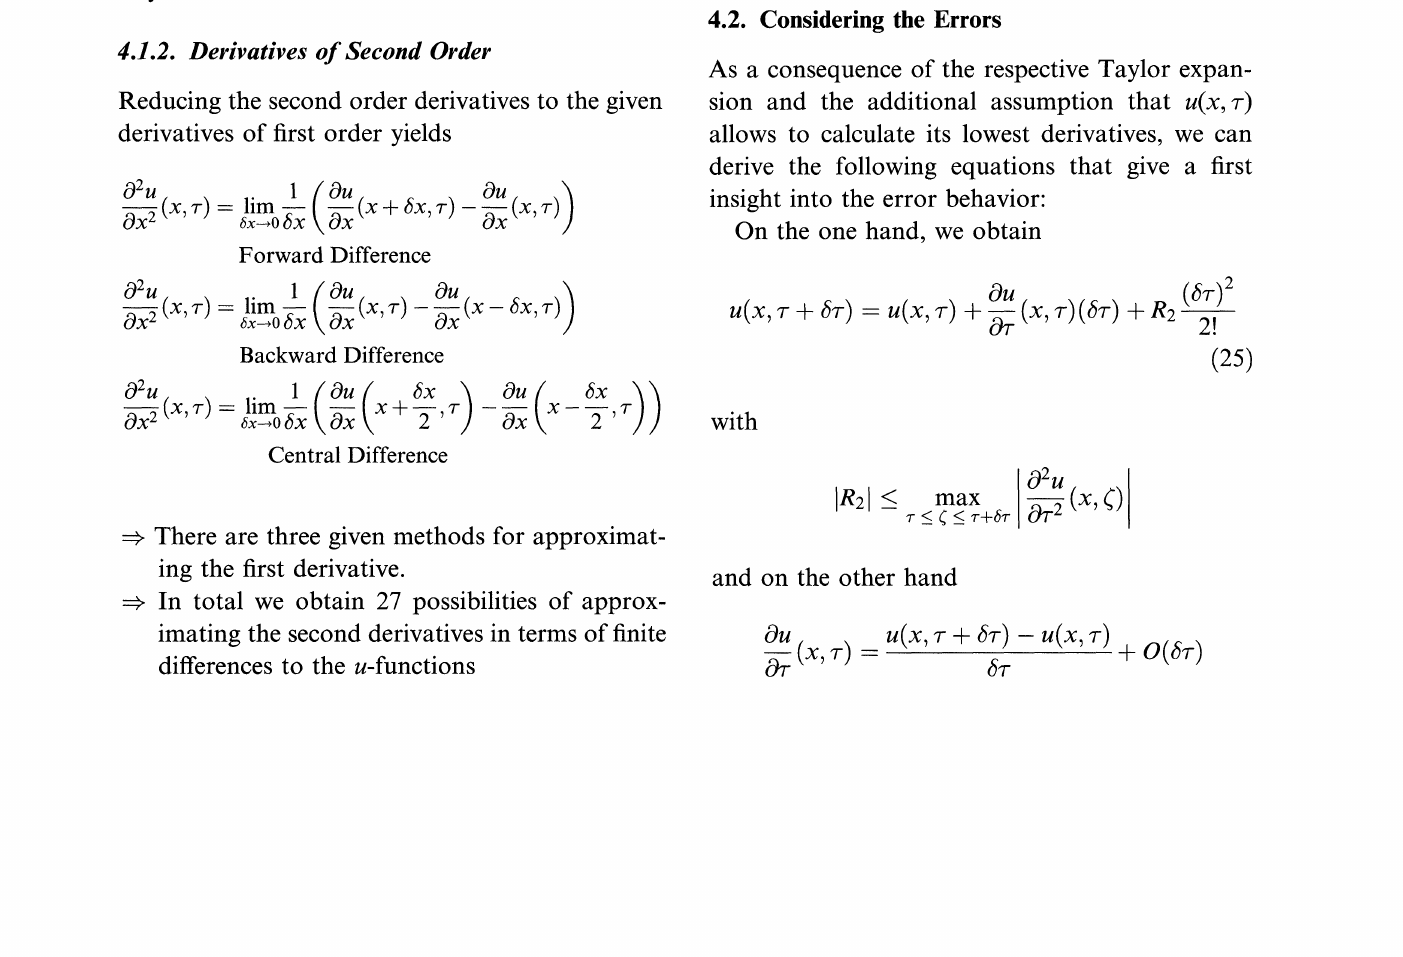
GRAPH 14 Forward Difference, Backward Difference and Central